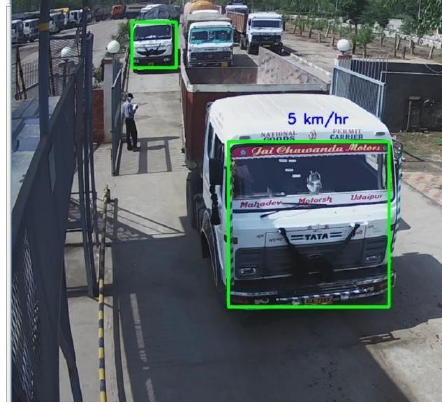
Fig. 14 : Vehicle Speed Detected